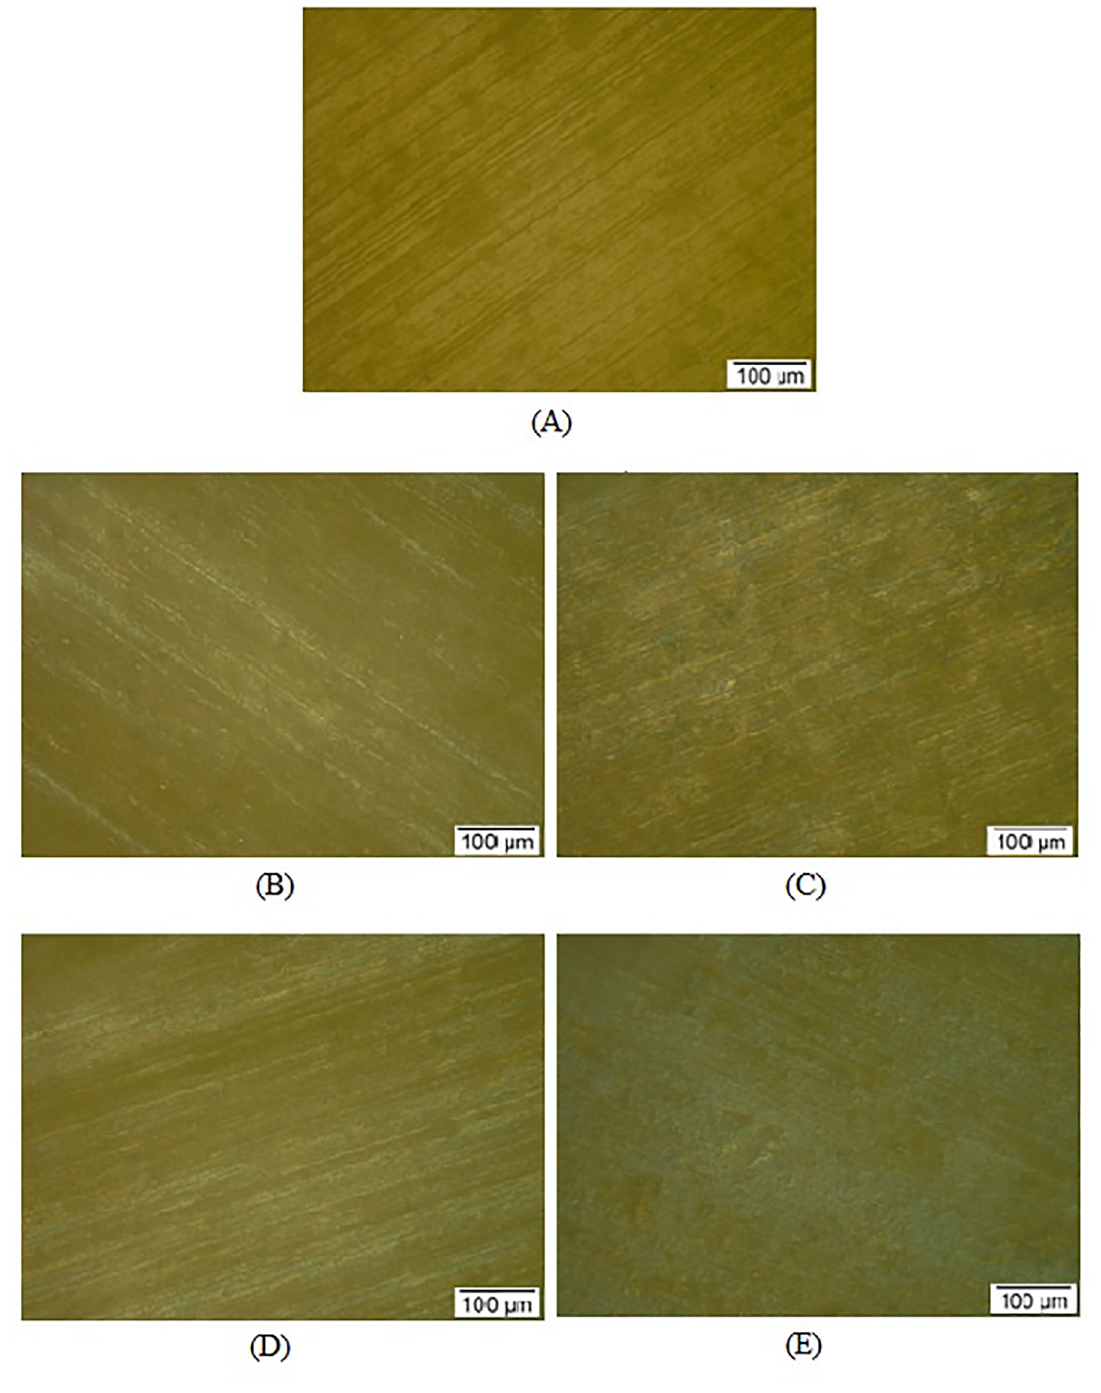
AlNbO ceramics before and after submersion in crude petroleum: (A) Before submersion Figure 4. Optical micrograph (200X) of Ba 2 6 in crude petroleum, (B and C) after 45 and 60 days submersion, respectively, in earthen crude petroleum and (D and E) after 45 and 60 days submersion, respectively, in offshore crude